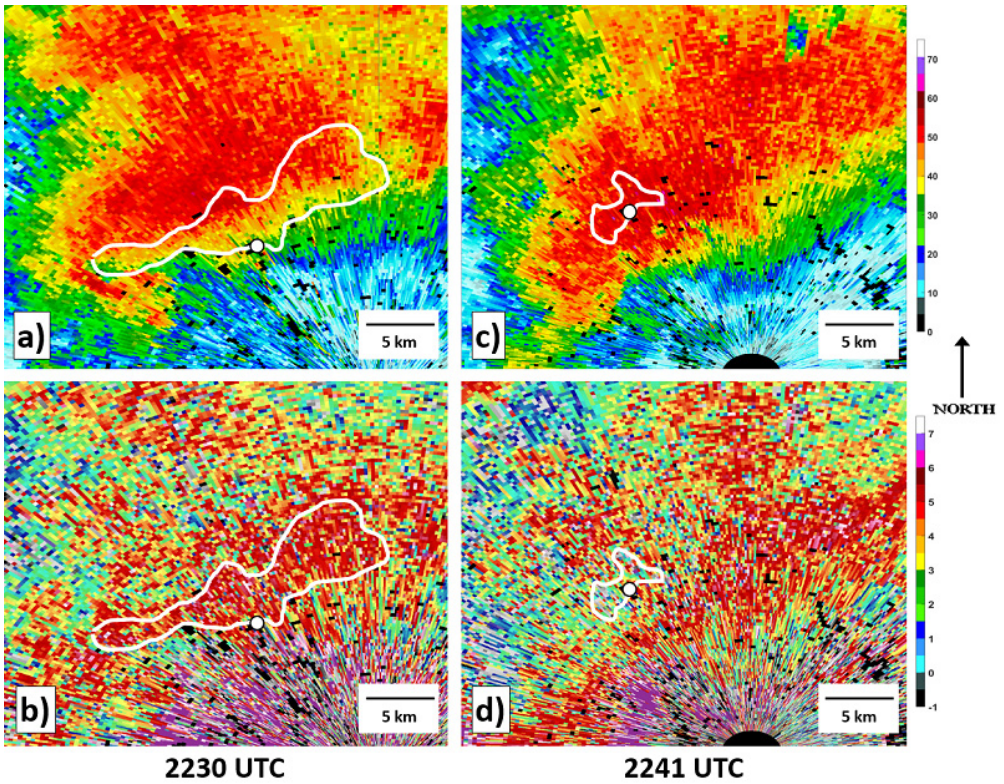
Figure 5. ( a , b ) show base-scan radar features of the supercell storm at 2230 UTC. ( a ) is Z HH (dBZ) and ( b ) is Z DR (dB). White outline indicates the approximate boundary of the Z DR arc region. ( c , d ) show similar data at 2241 UTC. In these panels, the white outline is the approximate region within which polarimetrically-inferred hail is occurring. In all panels, the white dot is the location of the ground-based instrumentation.